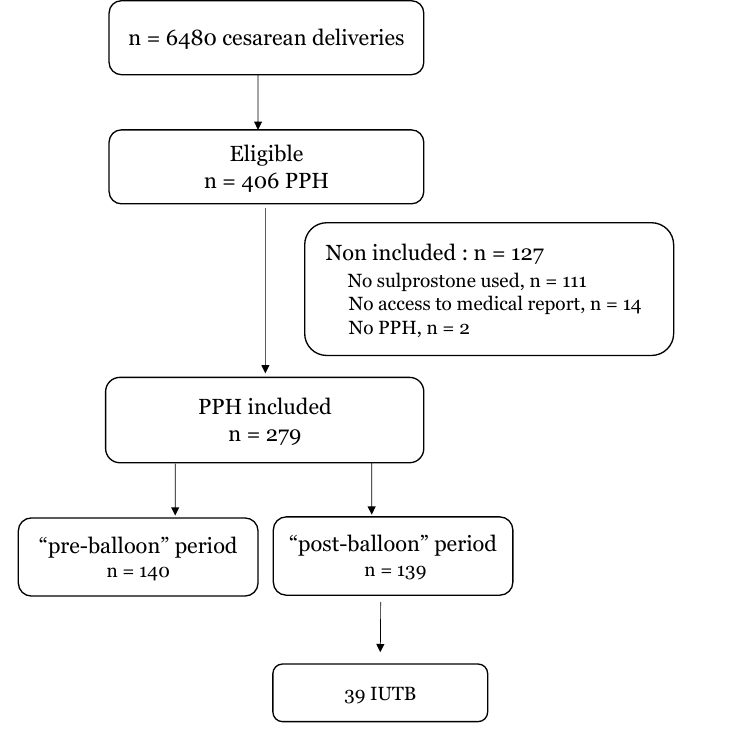
Figure 1. Flow chart representing eligible, included and non-included patients. PPH: post-partum hemorrhage; IUTB: intra-uterine tamponade balloon. Baseline characteristics are displayed in Table 1. There were no differences between Table 1. Detailed characteristics of patients with PPH